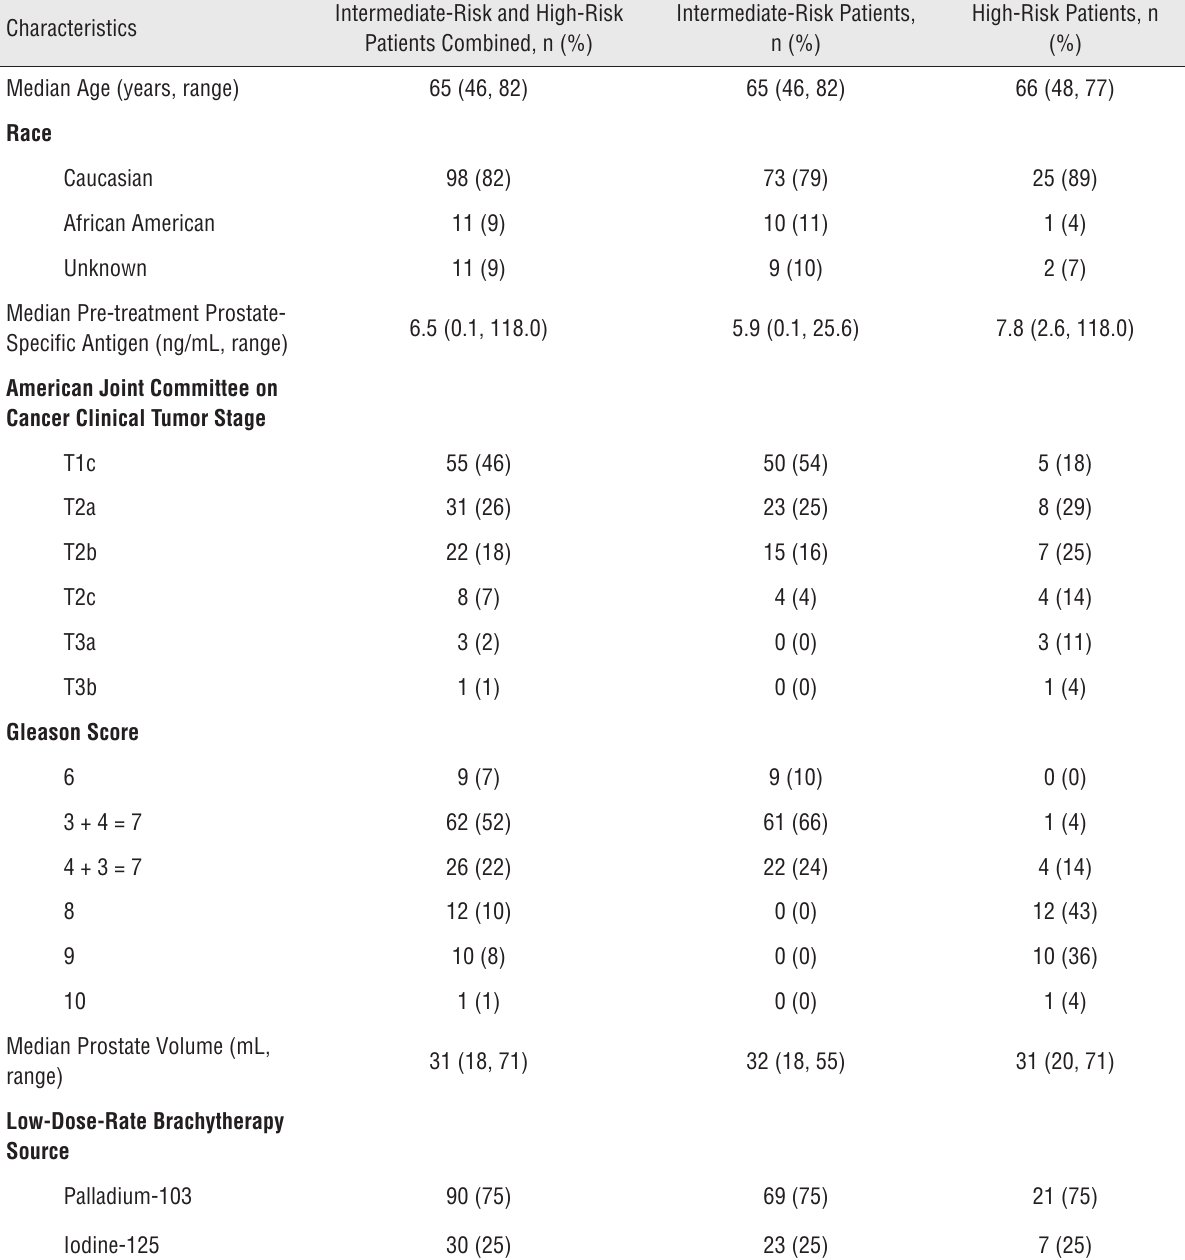
Table 1 - Characteristics of intermediate-risk and high-risk prostate cancer patients.